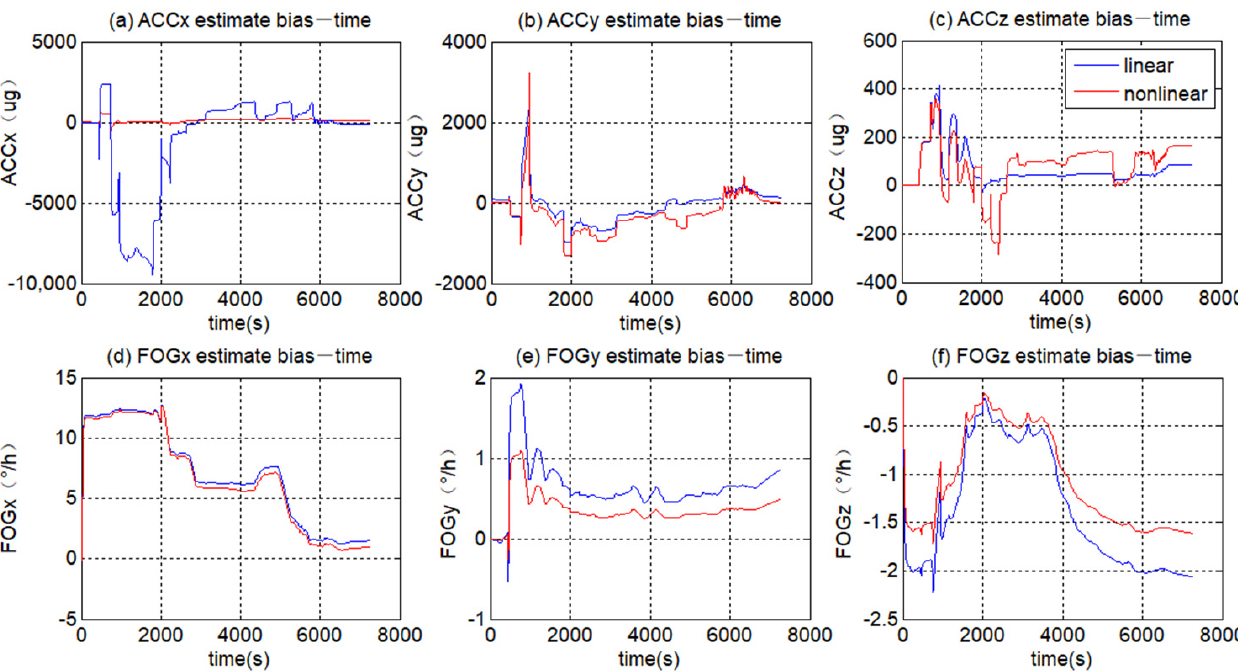
Figure A1. The estimated results of the Bias